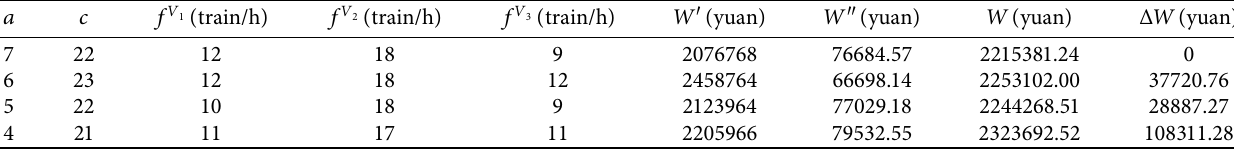
Table 6: Influence analyses of cross-line’s origination and destination setting on computing results.